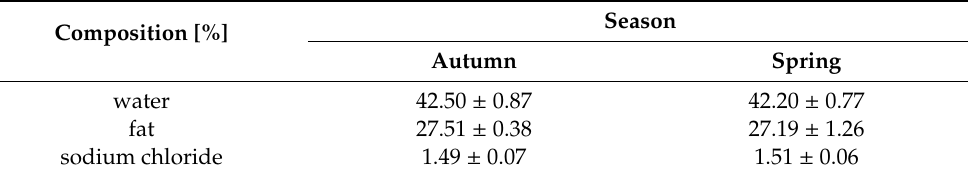
Table 2. Chemical composition of Edam cheeses